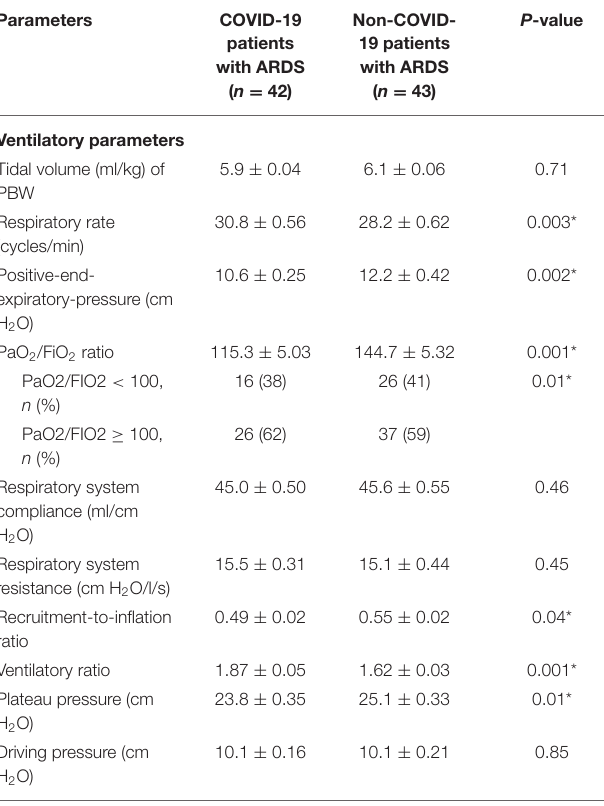
TABLE 2 | Respiratory mechanics of forty-two COVID-19 patients and forty-three non-COVID-19 patients with acute respiratory distress syndrome.